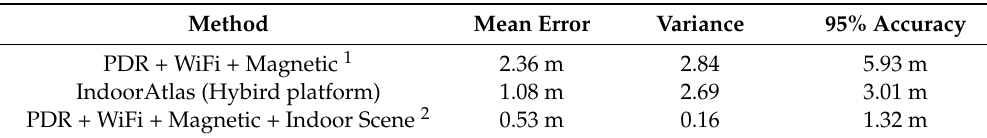
Table 4. Comparison of error statistics.